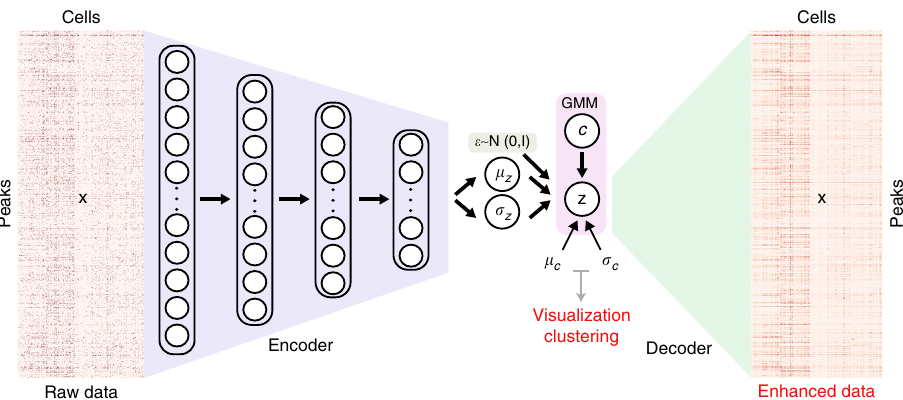
Fig. 1 Overview of the SCALE framework. SCALE consists of an encoder and a decoder in the VAE framework. The encoder is a four-layer neural network (3200 – 1600 – 800 – 400) and the decoder is a network of only one layer with 10-dimensional latent variables (features) directly connected to the output. The latent variables are on the GMM manifold parameterized by μ c and σ